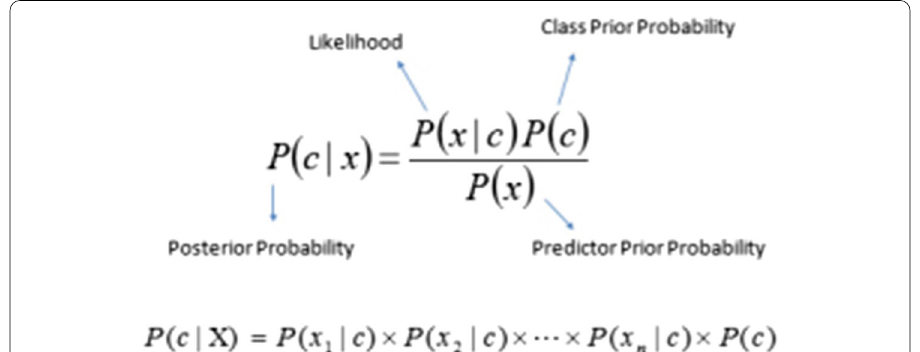
Fig. 3 Naïve Bayes probability